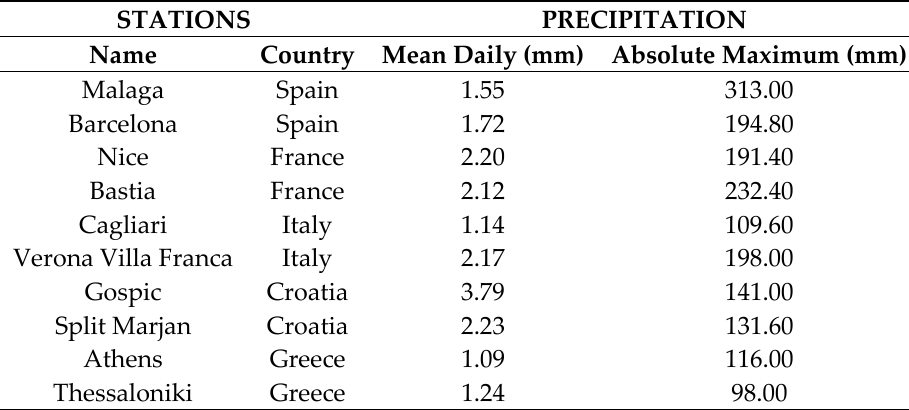
Table 1. An overview of rainfalls in the 10 studied